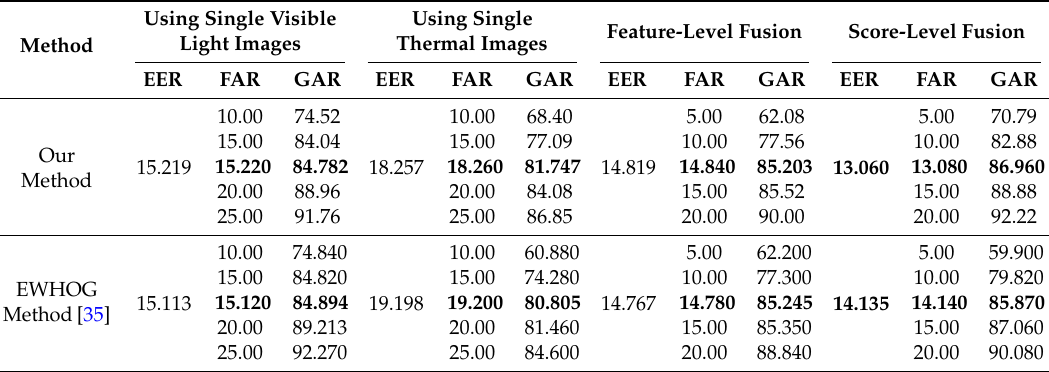
Table 13. Recognition accuracy using EWHOG method (unit: %).